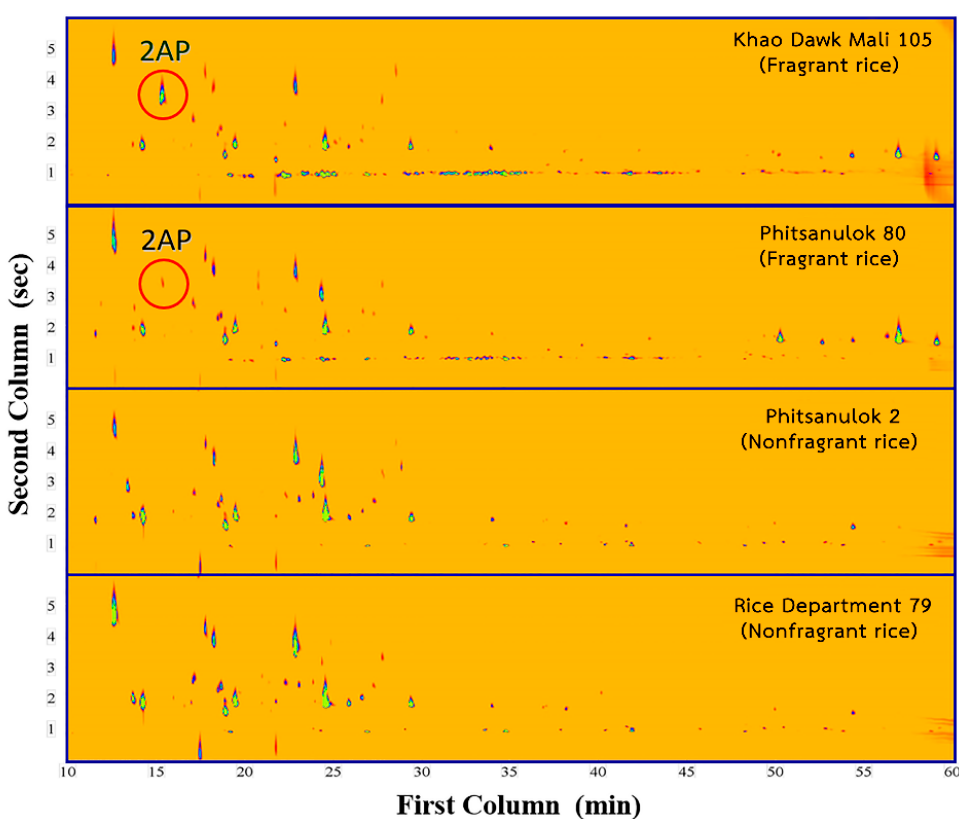
Figure 3. GC–MS chromatogram of a fragrant rice extract before ( A ) and after ( B ) the addition of Cr(CO) 6 .